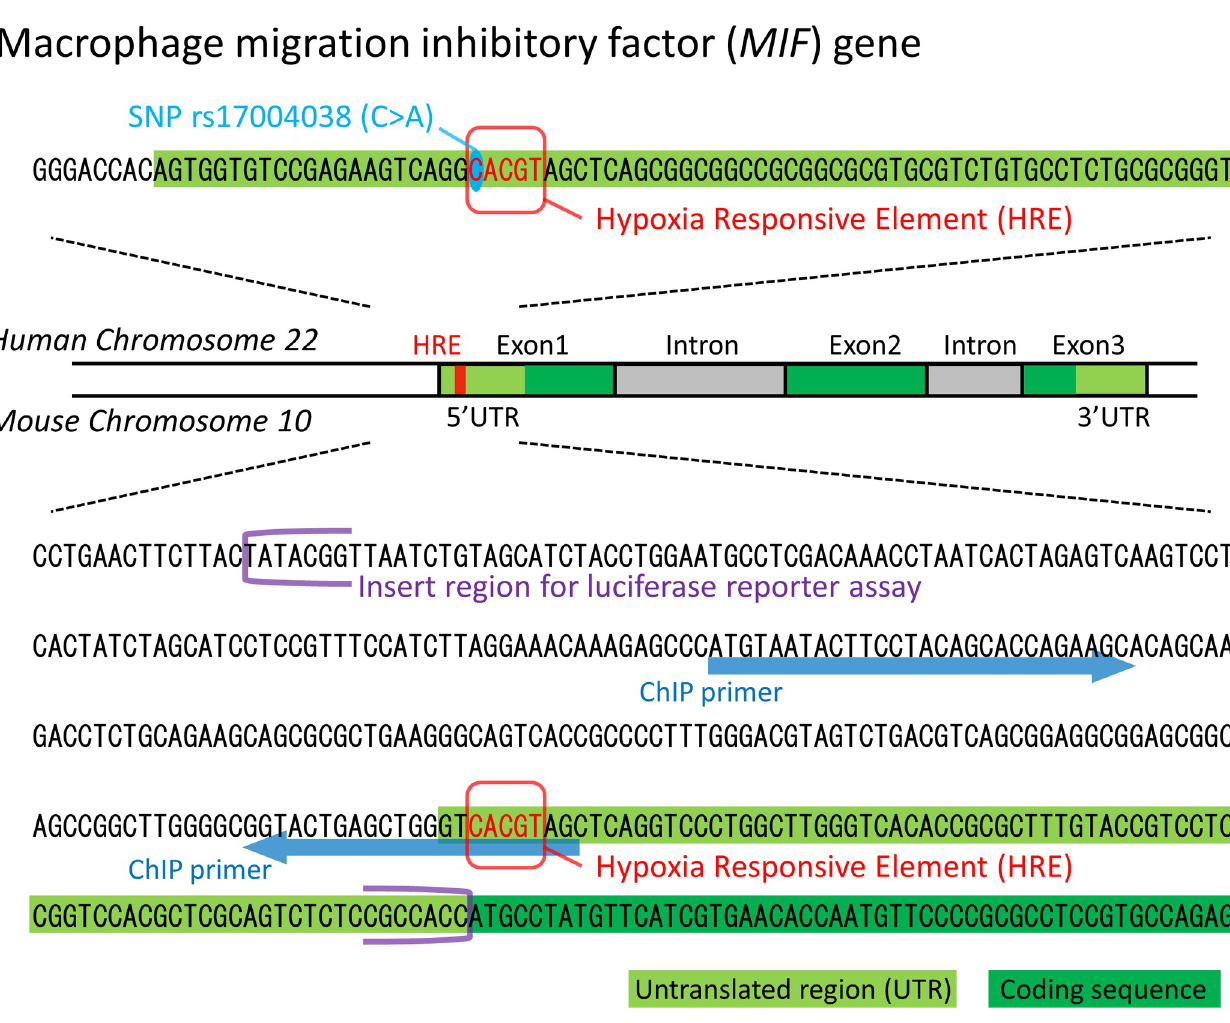
Fig 1. Human and mouse macrophage migration inhibitory factor ( MIF ) gene promoter